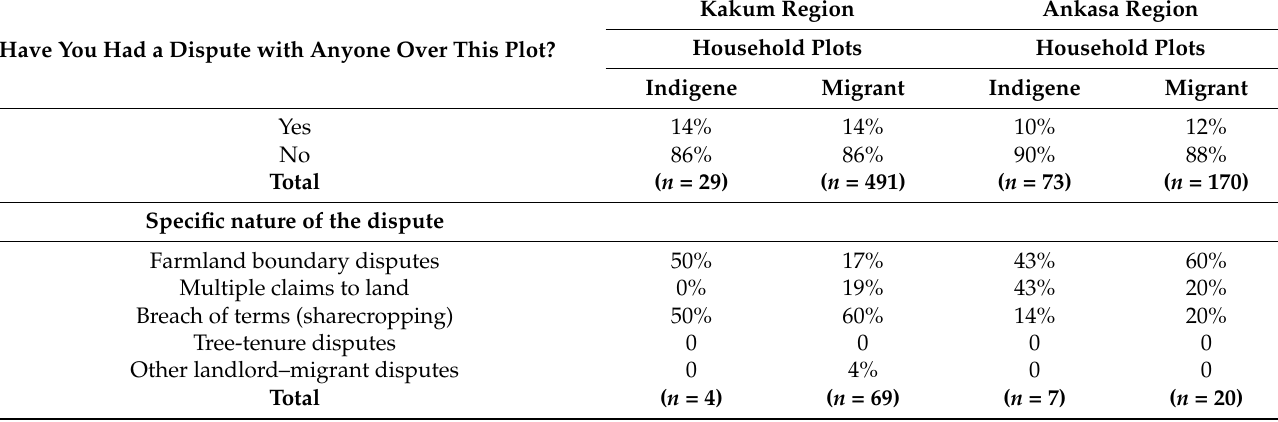
Table 2. Experience of previous disputes over household plots